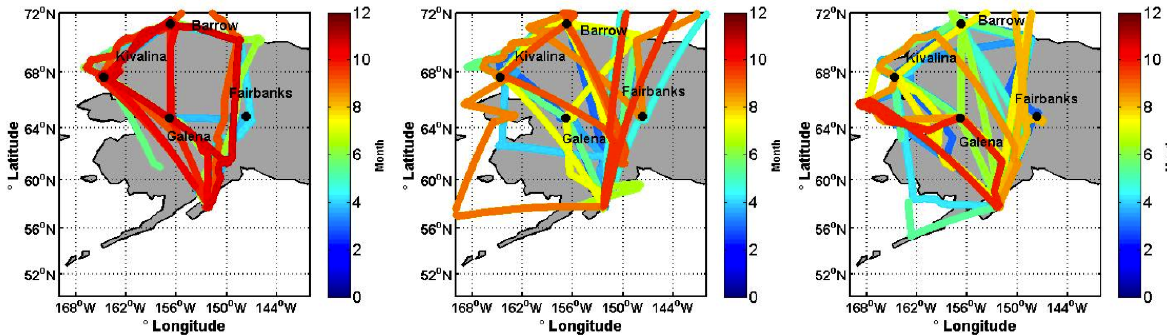
Fig. 1. Flight paths from the three complete seasons of GHG sampling: 2009 (left panel), 2010 (center panel), and 2011 (right panel). The color of the flight path corresponds to the month of the flight.